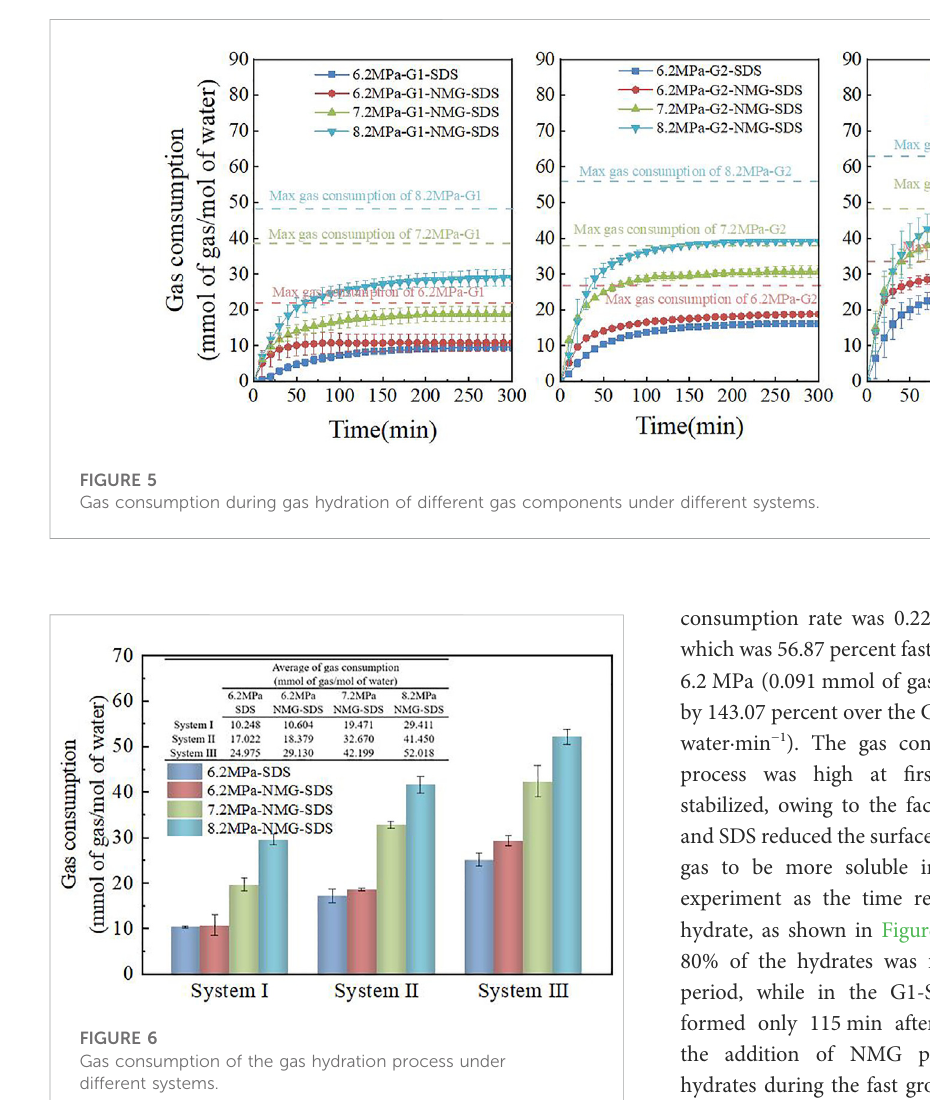
FIGURE 6 Gas consumption of the gas hydration process under different